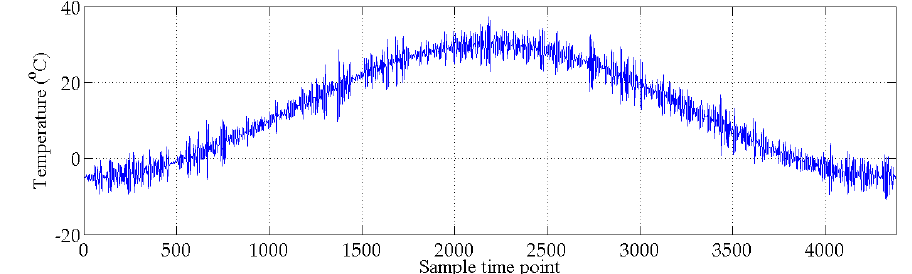
Figure 5 Simulated temperature variations.